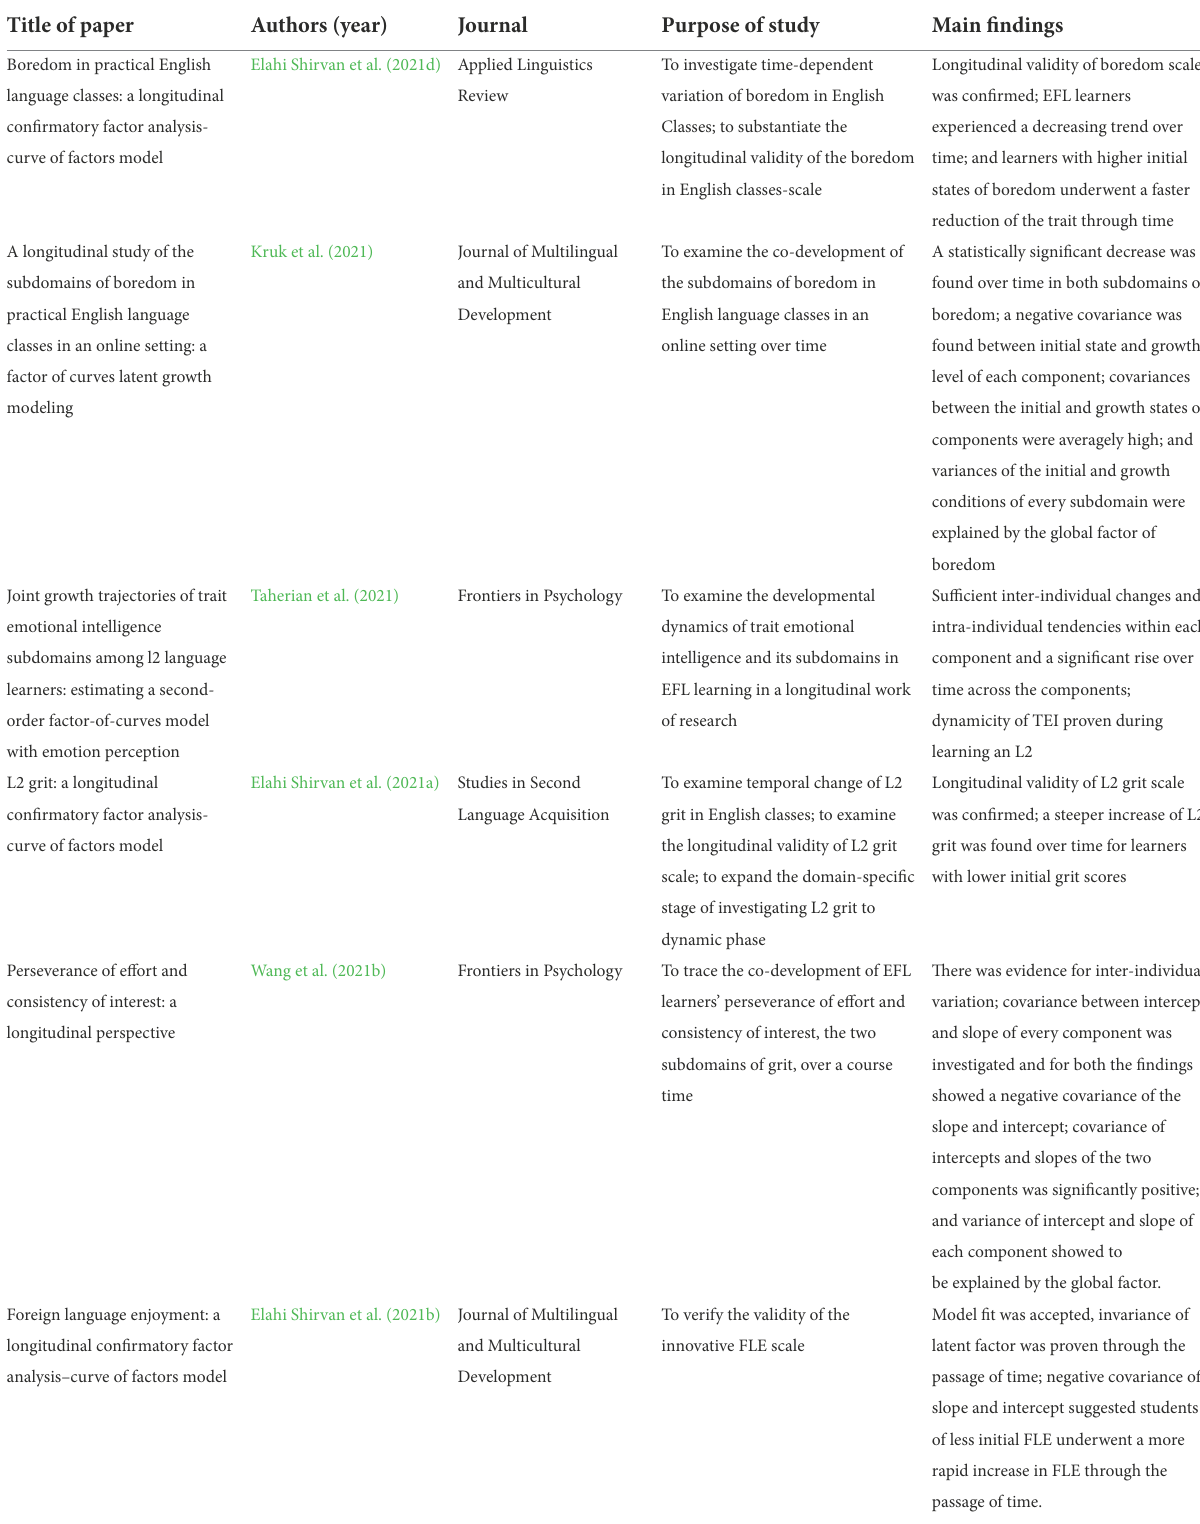
TABLE 1 A summary of the related literature on latent growth curve modeling in language